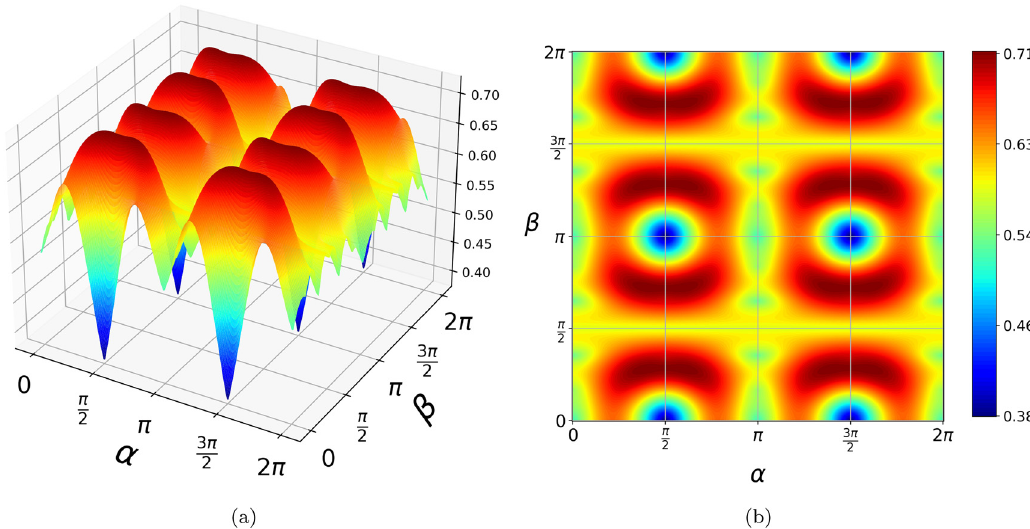
Figure 10: Solution space for case 2 based on equation ( 20 ) . ( a ) 3D graph for case 2. ( b ) Contour for case 2.